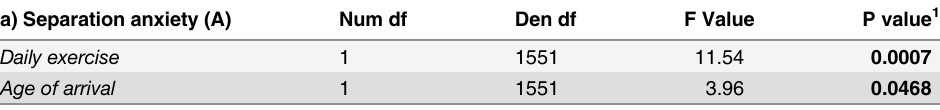
Table 4. Generalized linear mixed model analysis results on the association between environmental factors and separation anxiety. a) Separation anxiety (A)